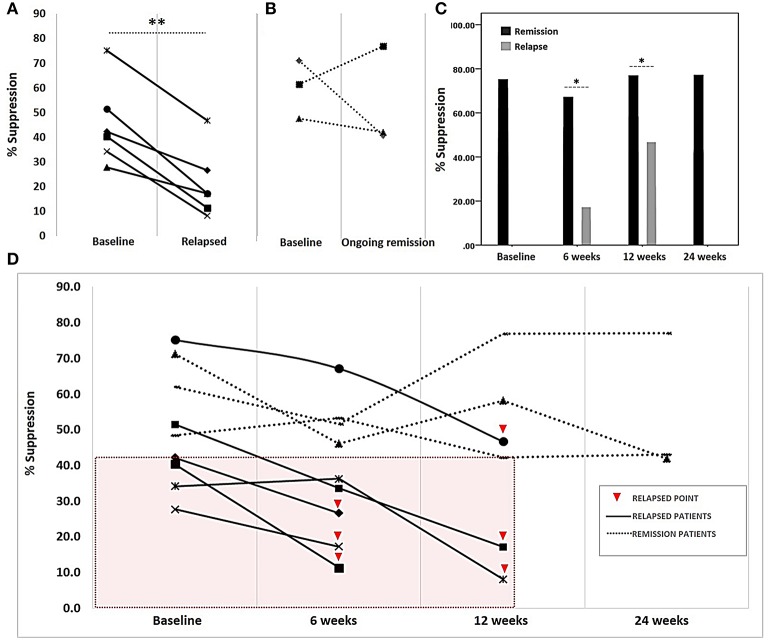
Treg suppressive activity in rheumatoid arthritis patients on a reduced disease-modifying anti-rheumatic drug regimen. Following co-cultivation of Tregs and autologous Tconv for 3 days, the proliferation of carboxyfluorescein succinimidyl ester (CFSE)-labeled Tconv was determined via flow cytometry. Treg suppressive activity, presented as percent suppression (100 – [%Tconv proliferation in co-culture]/[%Tconv proliferation in the absence of Treg] × 100), was determined at the time of drug regimen initiation (baseline) and at 6, 12, and 24 weeks thereafter. (A) Comparison of suppressive activity at baseline and disease relapse. (B) Suppressive activity in patients with ongoing remission at baseline and at the final visit at 24 weeks after drug reduction. (C) Comparison of suppressive activity between patients with ongoing remission and relapse during follow-up visits (6 and 12 weeks). (D) Suppressive activity in each patient (n = 9) at different time-points; boxed area (pink) indicates suppressive activities in only those patients with relapse who had a suppressive activity of <42%. Treg suppressive activity in all patients at the initiation of the study (baseline), patients in relapse at week 6 post-initiation (6 weeks), patients in relapse at week 12 post-initiation (12 weeks) and patients with ongoing remission at week 24 post-initiation (24 weeks). A comparison of suppressive activity at baseline and that after relapse was performed using a paired sample t-test. The comparison of suppressive activity at four visits and different visits was analyzed using Kruskall–Wallis and Mann–Whitney U-tests, respectively. Significance at p-value: *p < 0.05 and **p < 0.01.